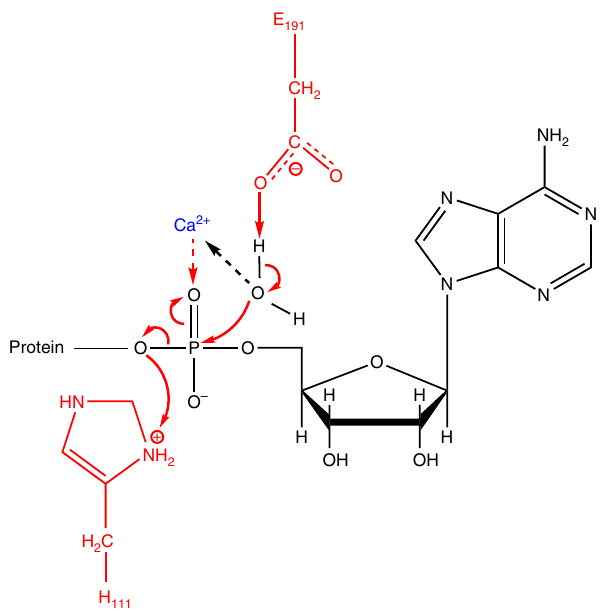
Fig. 5 Model of the Ca 2 + -assisted deAMPylation catalytic mechanism. In this model, the regulatory glutamate (Glu190 in EfFIC (FIC protein from Enterococcus faecalis )) attracts a proton from a water molecule coordinating the metallic cation (step 1) to activate the nucleophilic attack of its oxygen on the phosphorus of the AMP moiety of the AMPylated substrate (step 2). The positive charge provided by Ca 2 + increases electrophilicity of the phosphorus and stabilizes the negative charge of the intermediate (steps 2 and 3). The intermediate harboring a pentavalent phosphorus then rearranges, leading to the breaking of the phosphor-ester bond, which is elicited by the capture of a proton provided by the catalytic histidine (step